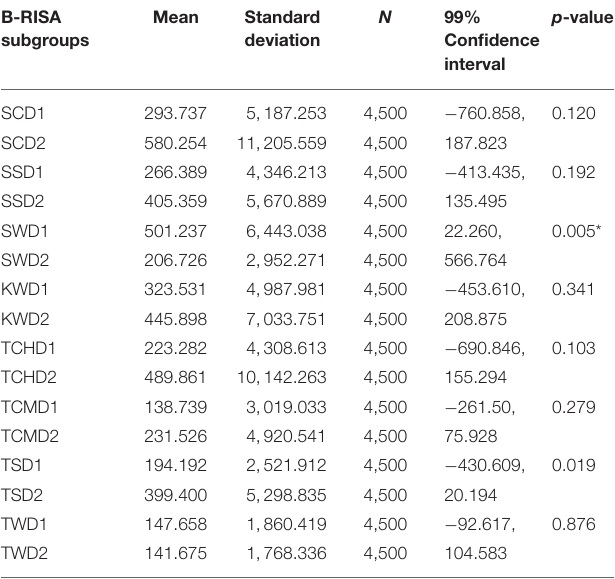
TABLE 3 | Determination of significant differences between B-RISA subgroups by student’s t -test for prokaryotic communities. B-RISA